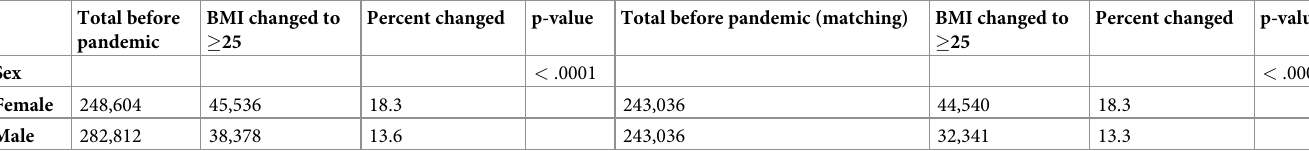
Table 2. Change from normal BMI category to overweight/obese category, pre-pandemic to May, 2022. Total before